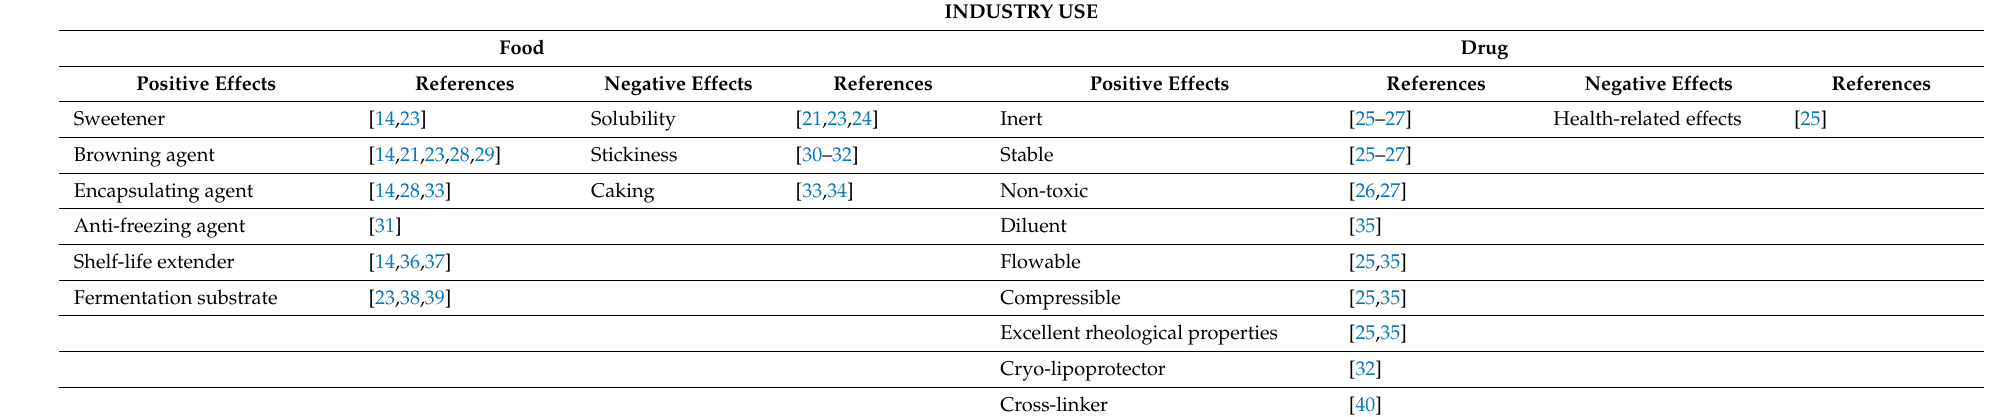
Table 1. Main positive and negative effects of lactose in food and drugs.